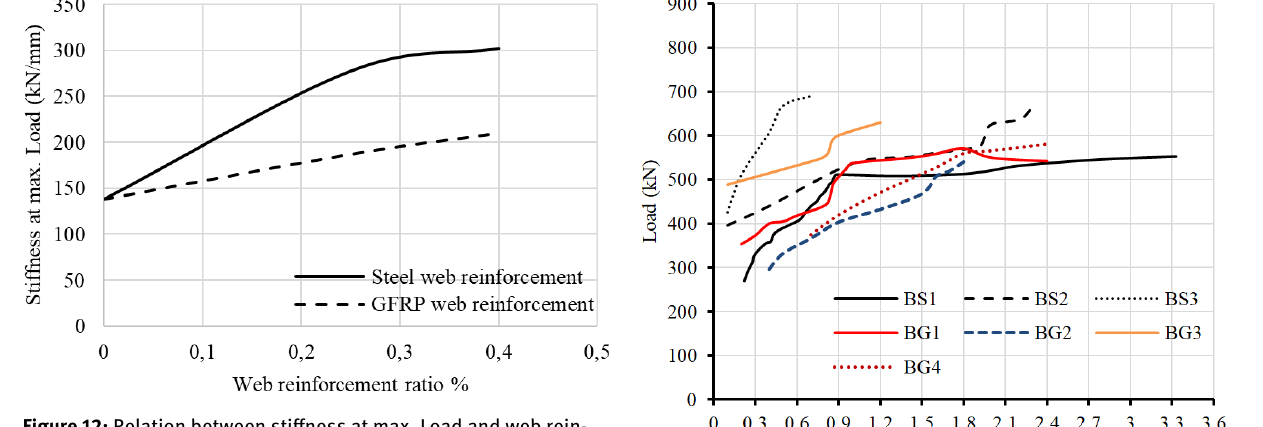
Figure 12: Relation between stiffness at max. Load and web rein- forcement ratio